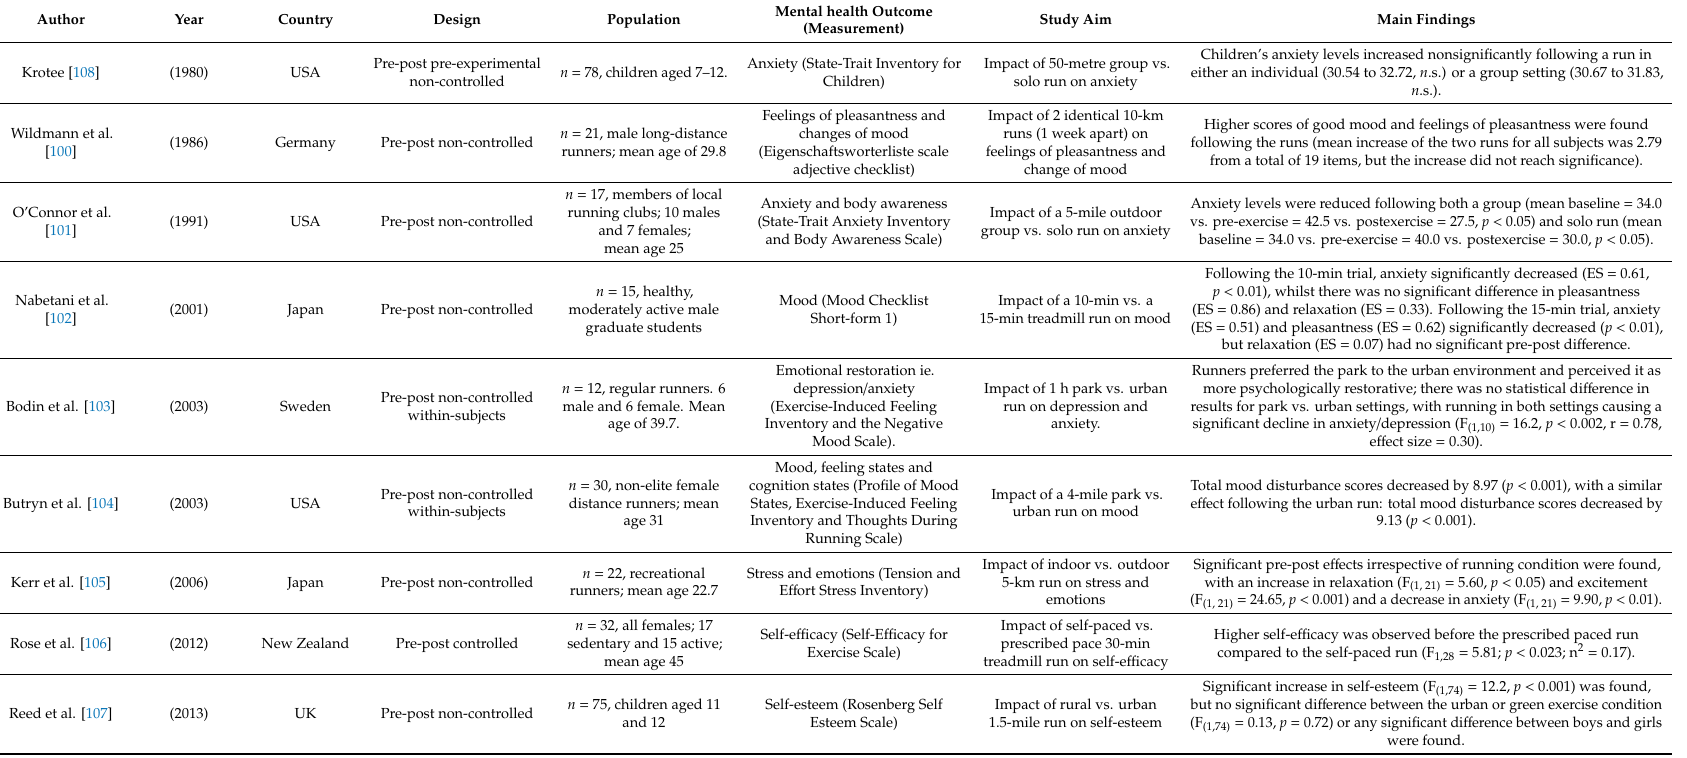
Table 4. Summary of data extraction from the 9 double-bout